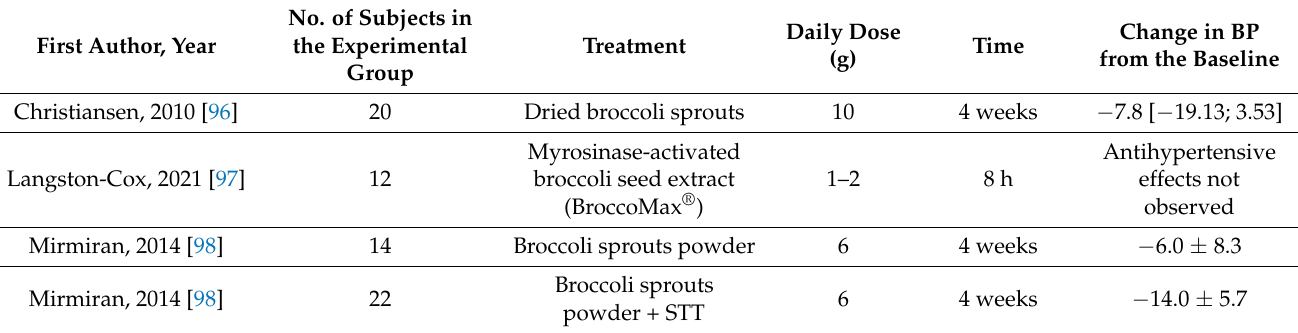
Table 4. Antihypertensive effects of broccoli in clinical studies. All values refer to systolic blood pressure (BP) expressed in mmHg and reported as mean [95% CI] or mean ± SEM. STT: standard